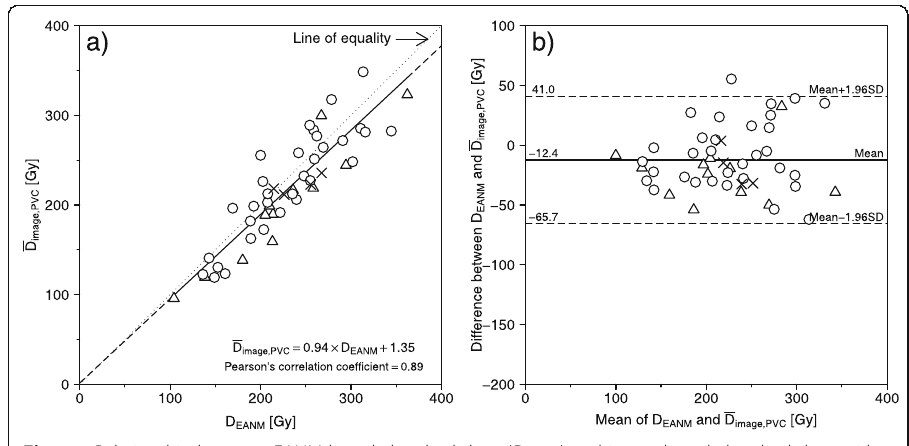
Fig. 4 a Relationship between EANM-based absorbed dose ( D EANM ) and image-based absorbed dose with PVC ( D image ; PVC ), using the regression equation: D image ; PVC ¼ 0 : 94 (cid:5) D EANM þ 1 : 35 (95% CIs of slope and y - intercept= 0.80 – 1.08 and − 32.2 – 34.8, respectively]. b The Bland-Altman analysis was performed between D − 12.4 Gy [95% CI = − 20.3 to − 4.4]) but no proportional D image ; PVC . There was also fixed bias ( EANM and bias (Pearson ’ s correlation coefficient= 0.11 [95% CI = − 0.17 – 0.39]). Note that each symbol in the figure represents three therapeutic outcomes: open circle, hypothyroidism; open triangle, euthyroidism; and cross,